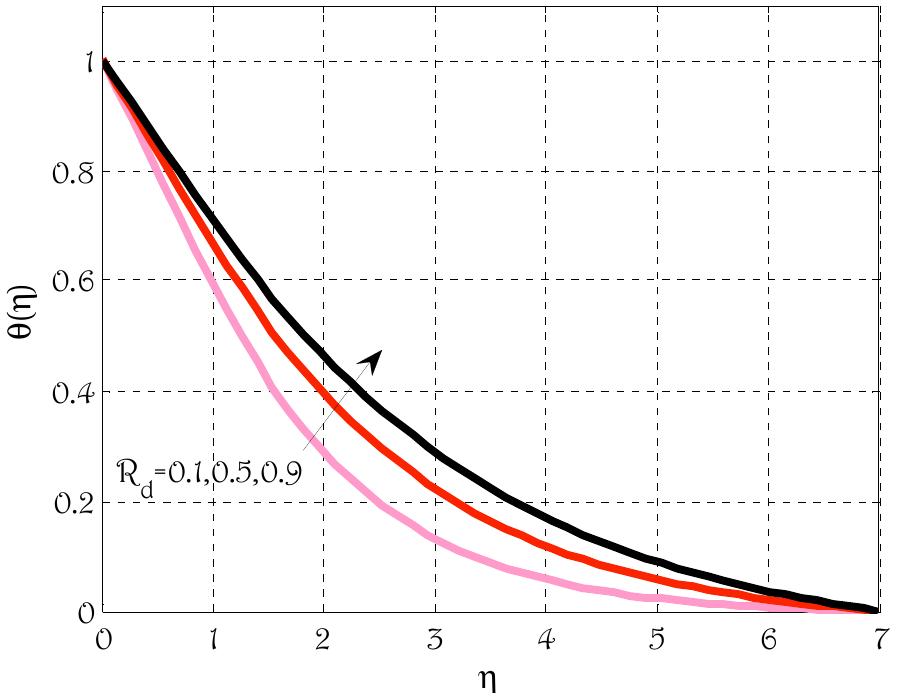
Figure 9. Effect of radiation parameter R d on temperature profile θ using k p = 0.5, M = 0.5, E c = 0.4, λ = 0.7, N t = 0.1, N b = 0.1, P r = 1.5, S c = 1.5, γ =